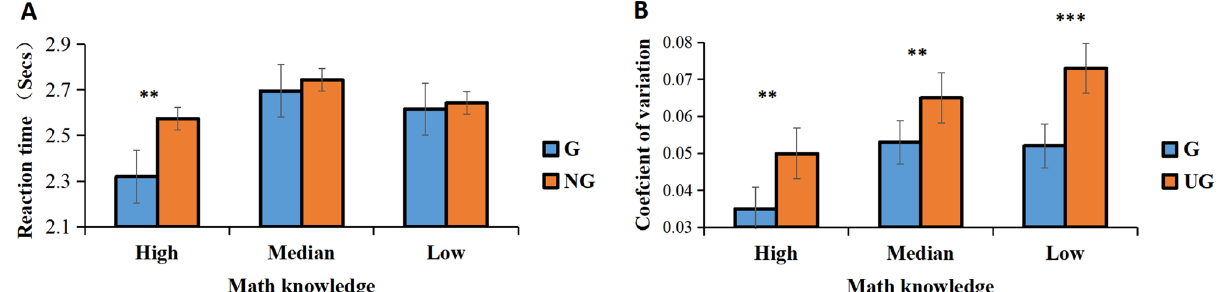
Figure 6. Results for math knowledge. RTs ( A ) and CV ( B ) in groups with high, medium, and low levels of math knowledge by group condition. *** p < 0.001; ** p < 0.01; * p <